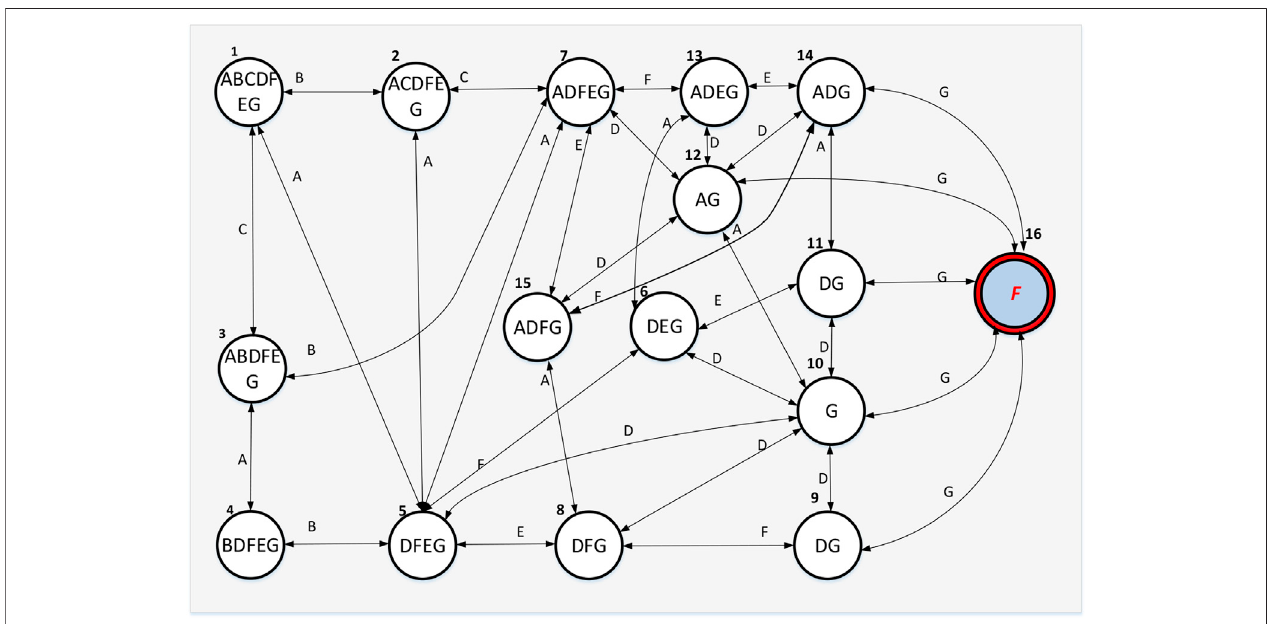
FIGURE 7 | Markov chain model of the Diesel Generator